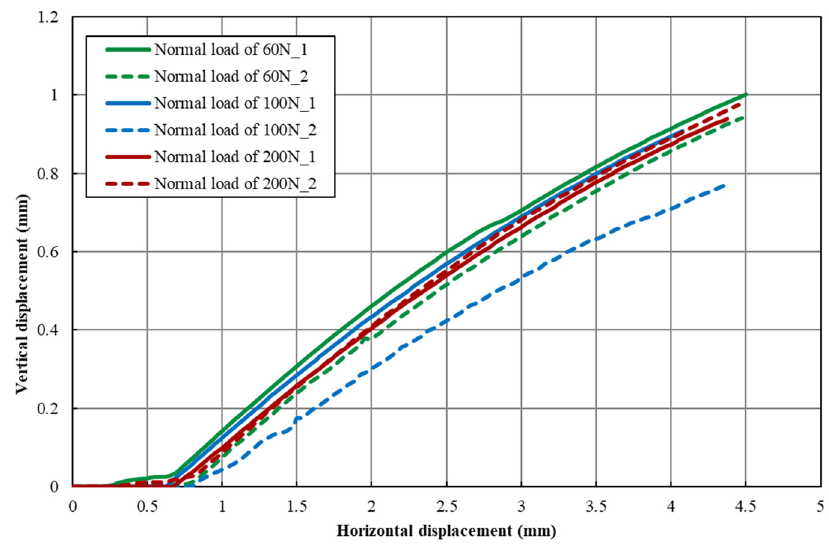
Figure 6. Vertical displacement versus horizontal displacement for two groups of tests (under normal loads of 60, 100, and 200 N).